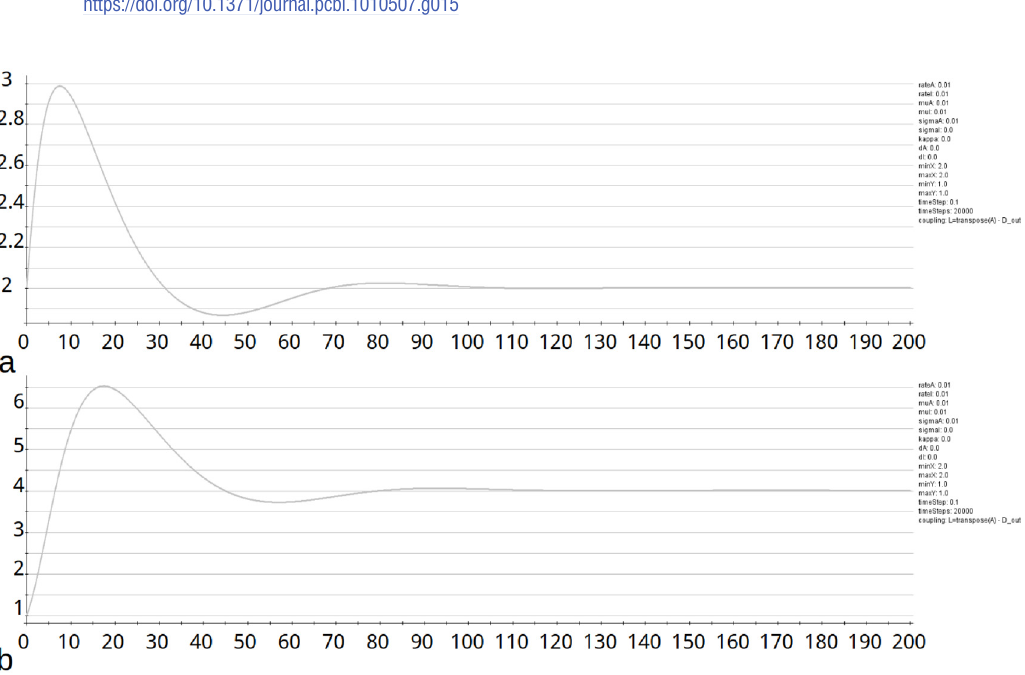
Fig 16. Stability of function u and v . a) The GM model was applied to exactly one non-connected node to show that the function u has a stable progression above a certain number of iterations. The function of u for a = b = 0.01 shows stability at about 100 iterations. b) For the same parameters as given before, the function v is given.